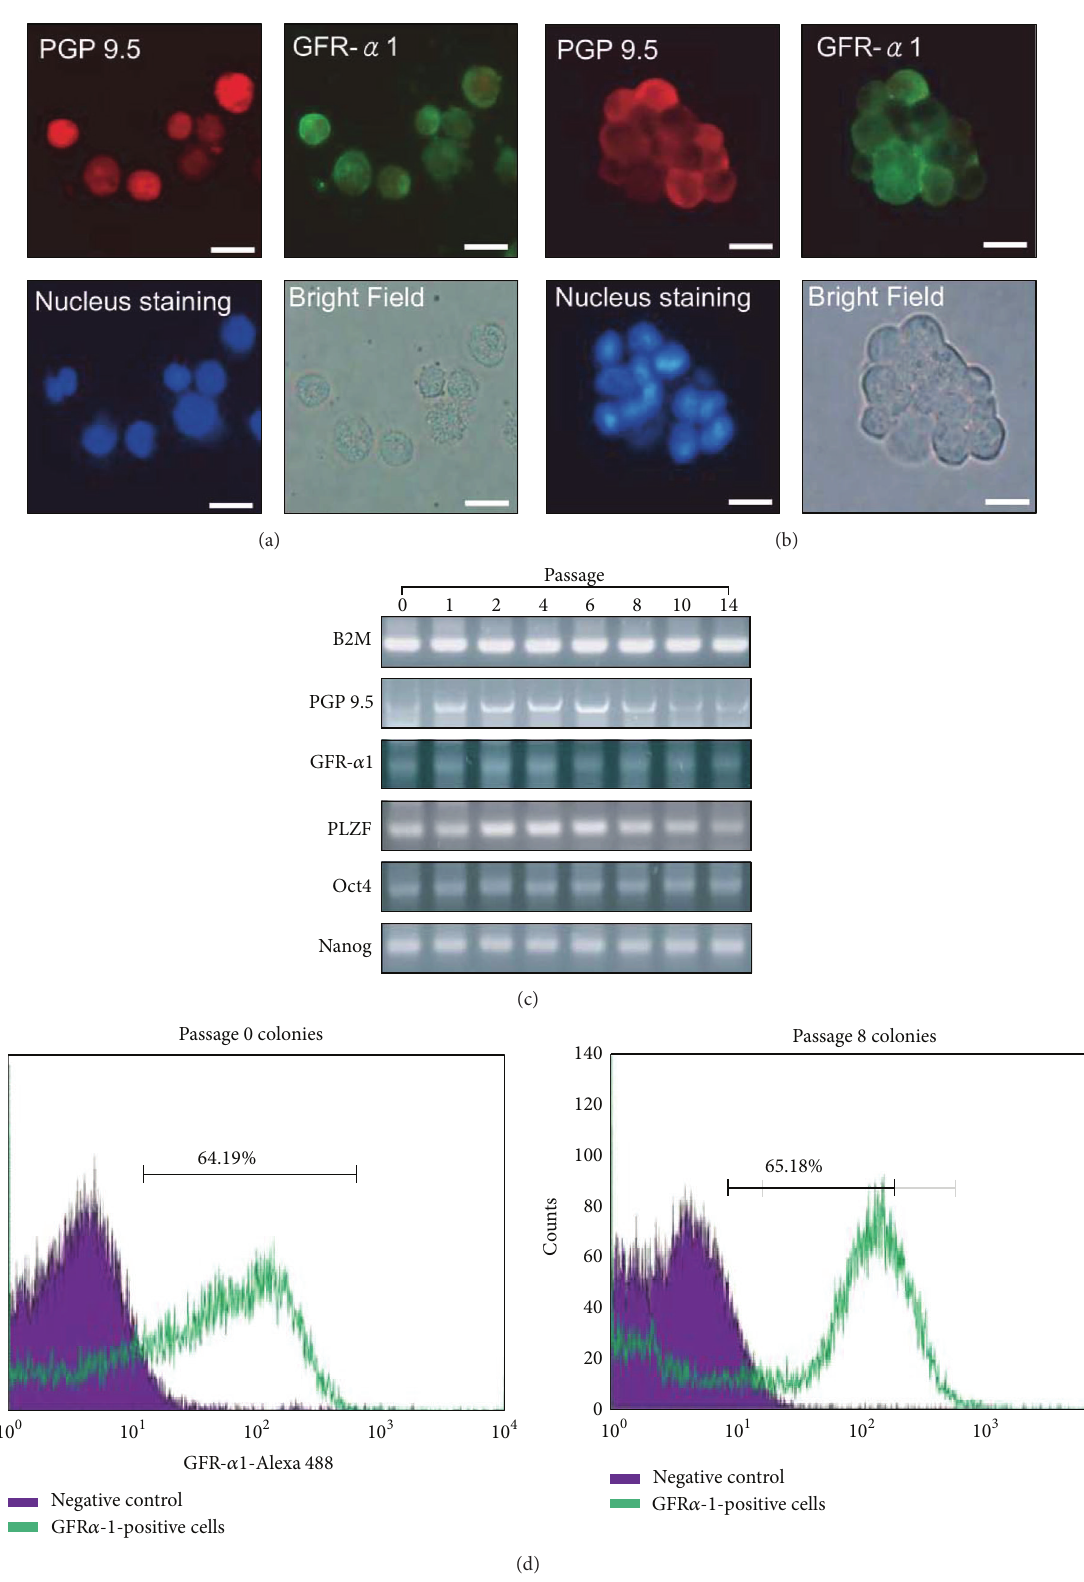
Figure 4: Characterization of germ cell-derived colonies in subculture. The GDC cells in passages 2 and 11 were stained with antibodies against PGP 9.5 and GFR 𝛼 -1 ((a) and (b)), while the nuclei were stained with DAPI. Expression of germ and stem cell markers is shown in panel (c). The proportion of GFR 𝛼 -1-positive cells, analyzed in passages 0 and 8, is shown in panel (d). Scale bars indicate 10 𝜇 m in panels of (a) and